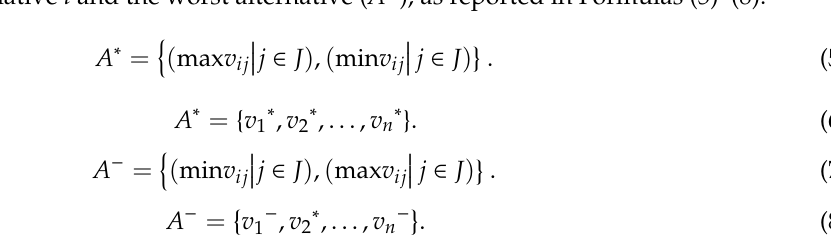
Table 2. Transportation purposes of Tehran at 2025 horizon.